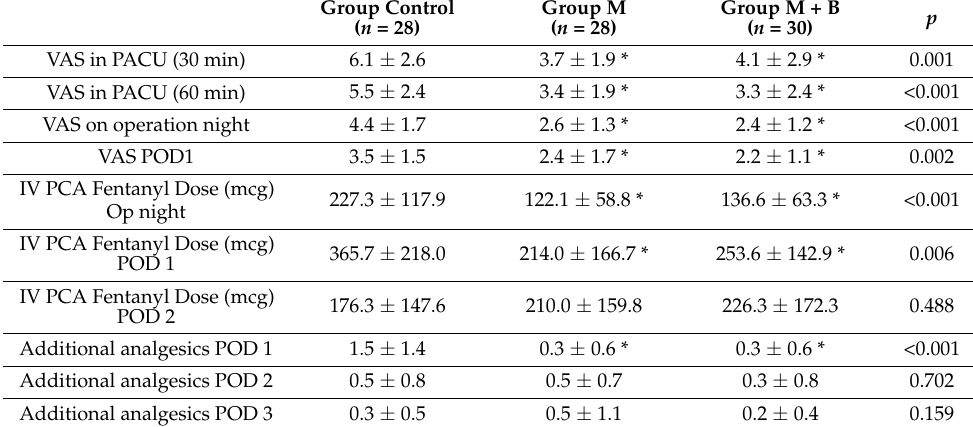
Table 2. Pain score and additional analgesics required in the postoperative period.